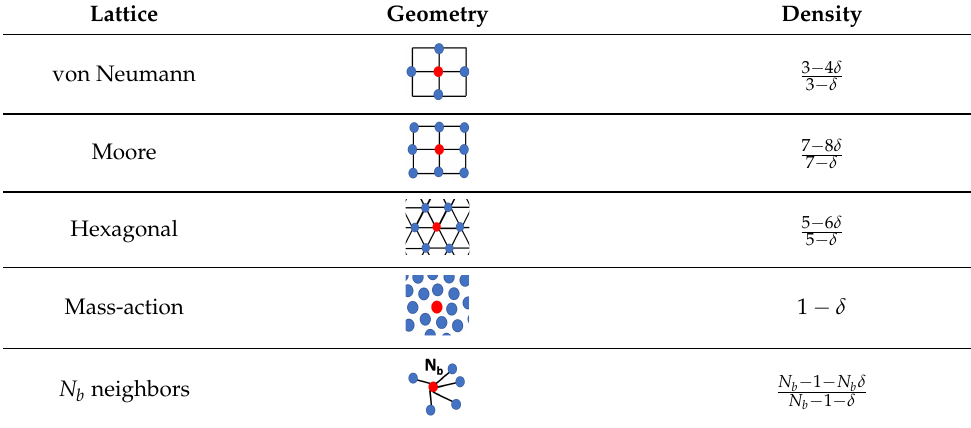
Table 1. Steady-state densities for different types of lattices, as well as the mass-action system and a generalized, N b -neighbor system; see [20]. Here, δ = D / L , the division-to-death rate ratio. Red dots denote the focal cell and the blue ones stand for its